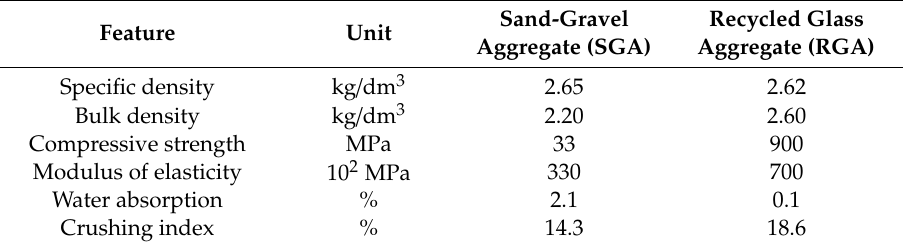
Table 3. Properties of recycled glass aggregate (RGA) and sand-gravel aggregate